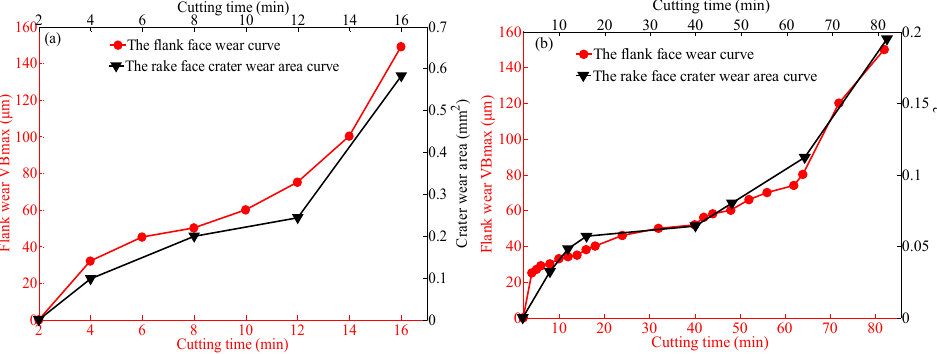
Figure 12. ( a ) Crater wear area of the rake face and wear width of the flank face of Tool A with time. ( b ) Crater wear area of the rake face and wear width of the flank face of Tool B with time.